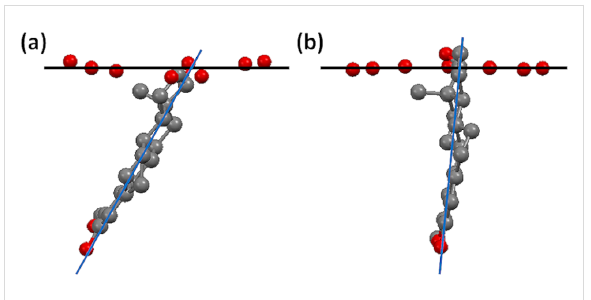
Figure 5: Inclination of the mean plane of the included 2ME molecule relative to the O4-heptagon of the host molecule in (a) complex unit A of TRIMEB·2ME, (b) the complex DIMEB·2ME. The respective inter- planar angles are ≈ 60° and ≈